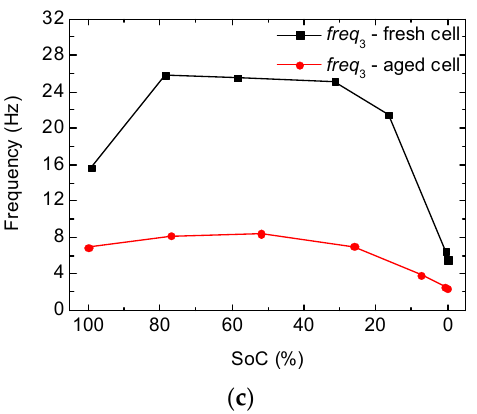
Figure 13. ( a ) Resistance, ( b ) capacitance, and ( c ) characteristic frequency related to P3_FC measured at the LCO-NMC/graphite full-cell at 25 °C. This has been related to charge transfer at positive electrode.